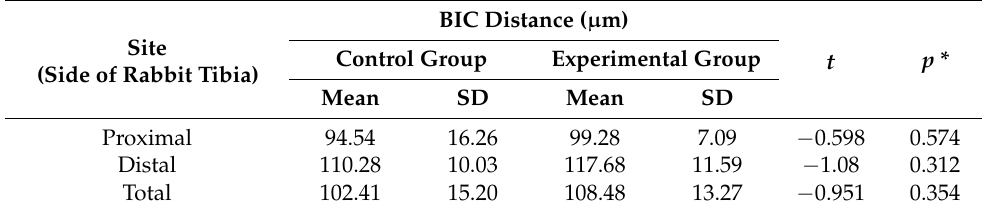
Table 3. Comparison of the bone-to-implant contact (BIC) distance ( µ m) between the experimental Table 2. Comparison of the bone-to-implant contact (BIC) ratio (%) between the experimental and and control groups. control groups.